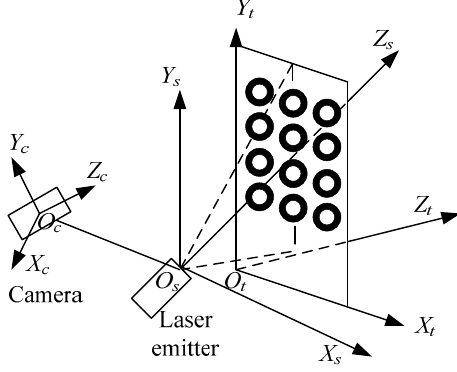
Figure 9. Sketch map for the defined coordinates of the sensor.